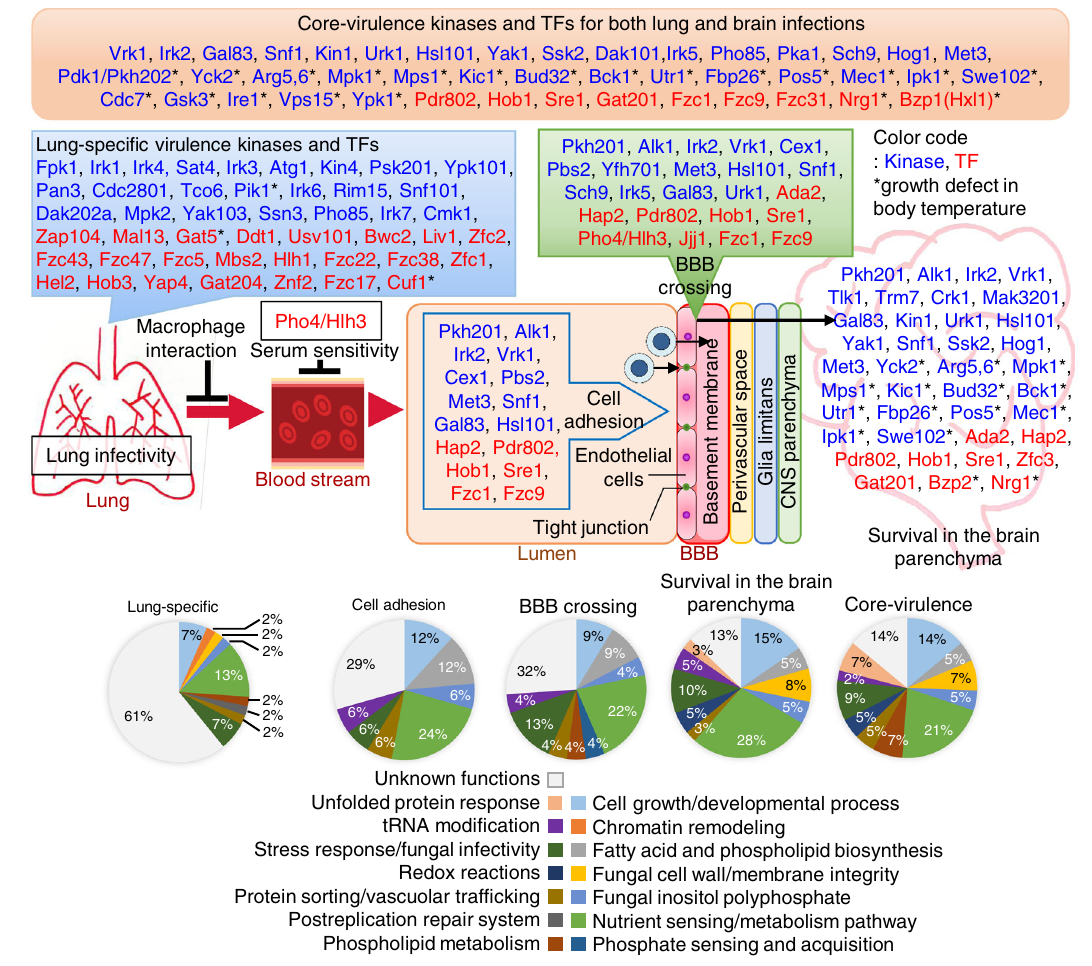
Fig. 7 The signalling network regulating brain infection in Cryptococcus neoformans . Gene Ontology (GO) term-based categorisation of lung-infection- related, brain-infection-related, and core-virulence kinases and TFs, which are summarised in Supplementary Data 2 and 3, are illustrated. Asterisk (*) indicates gene deletion mutants that exhibit growth defects at mammalian body temperature. Blue and red letters denote kinases and TFs, respectively, involved in the virulence of C. neoformans . Bold letters indicate kinases and TFs that play important roles in both BBB crossing and survival in brain